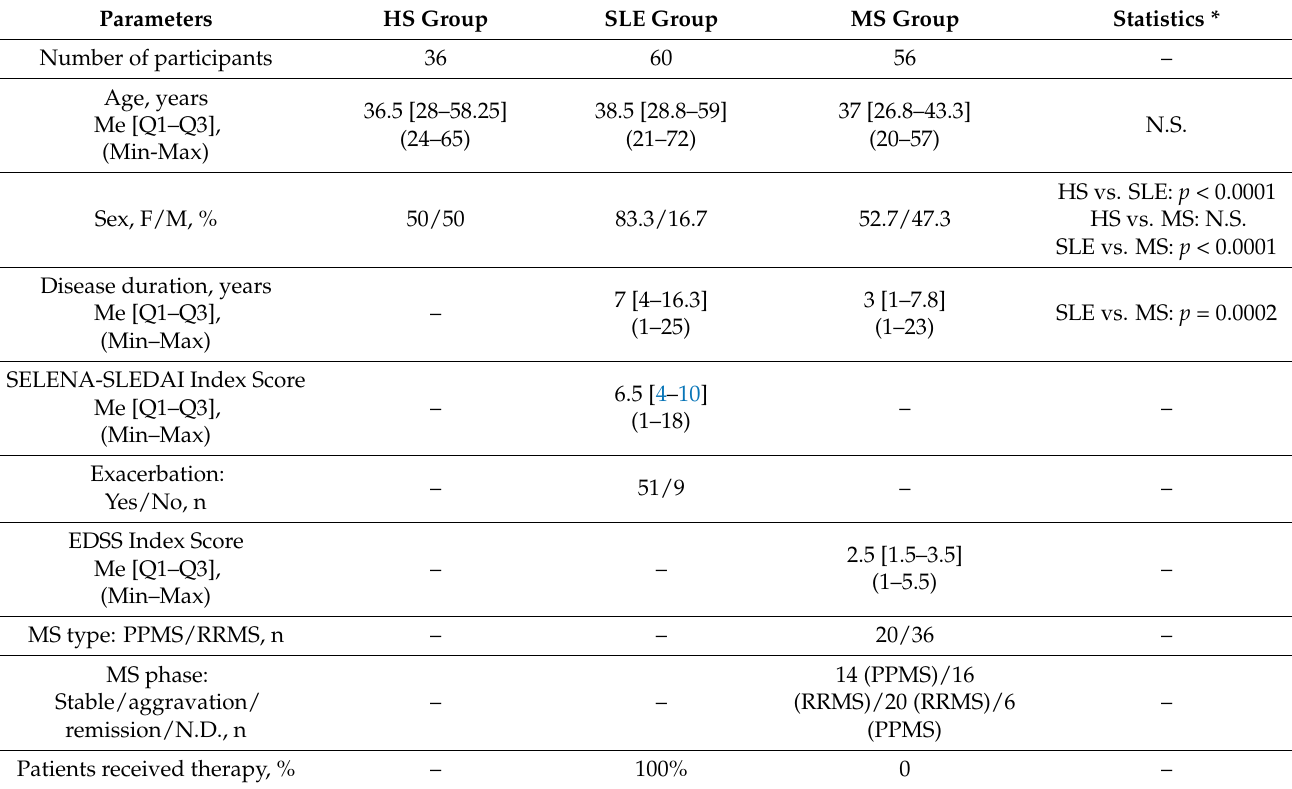
Table 1. Clinical characteristics of the studied groups of patients and healthy